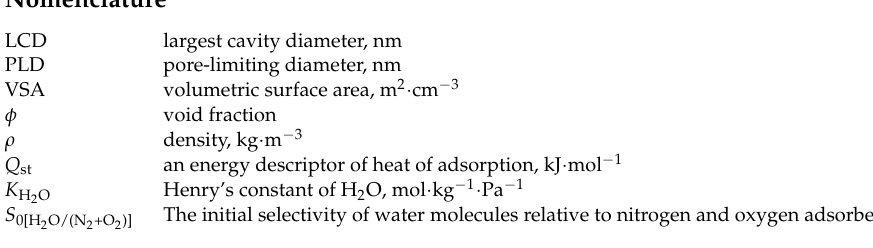
Figure S1: Models of N 2 and O 2 ; Table S2: Lennard-Jones parameters and charges of adsorbates; Ex- planation about calculation approach; Figure S2: Linear, binomial and trinomial fitting; Figures S3–S5: Details of three ML algorithms; Table S3: Type and the range of key parameters in the optimization; Table S4: Parameters of 4 ML; Table S5: Predictive importance of six descriptor by four ML algorithms; Table S6: Details of top ten hMOFs with optimal performance of water harvesting; Excel file: Top 200 CoRE-MOFs and